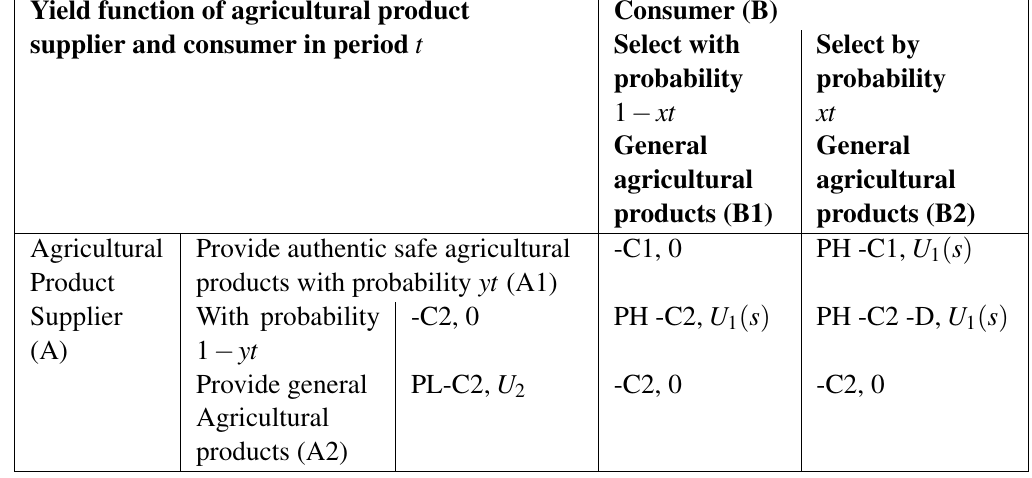
Table 2 Possible benefits of different strategic choices between suppliers and